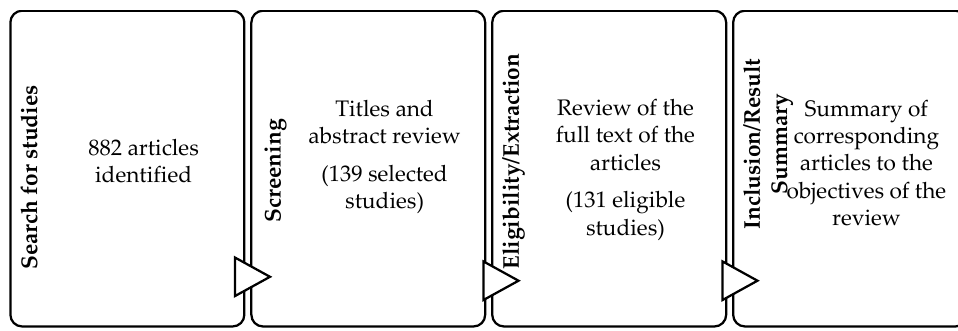
Figure 1. Stages of the systematic review on erosion processes in margins. The most frequently used keyword in the 882 articles analyzed was “bank erosion” ( n = 146 studies; 16.6%). Figure 2 shows the 25 main keywords used, as well as the three colored groups formed by their connection corresponding to the main research areas on this topic.